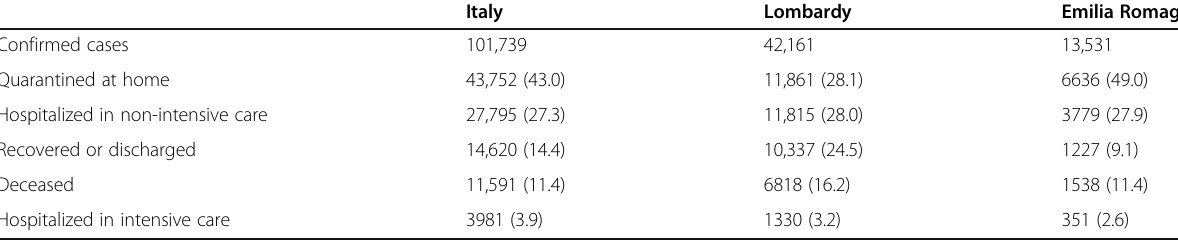
Table 1 Confirmed cases and patient categories updated to 30 March